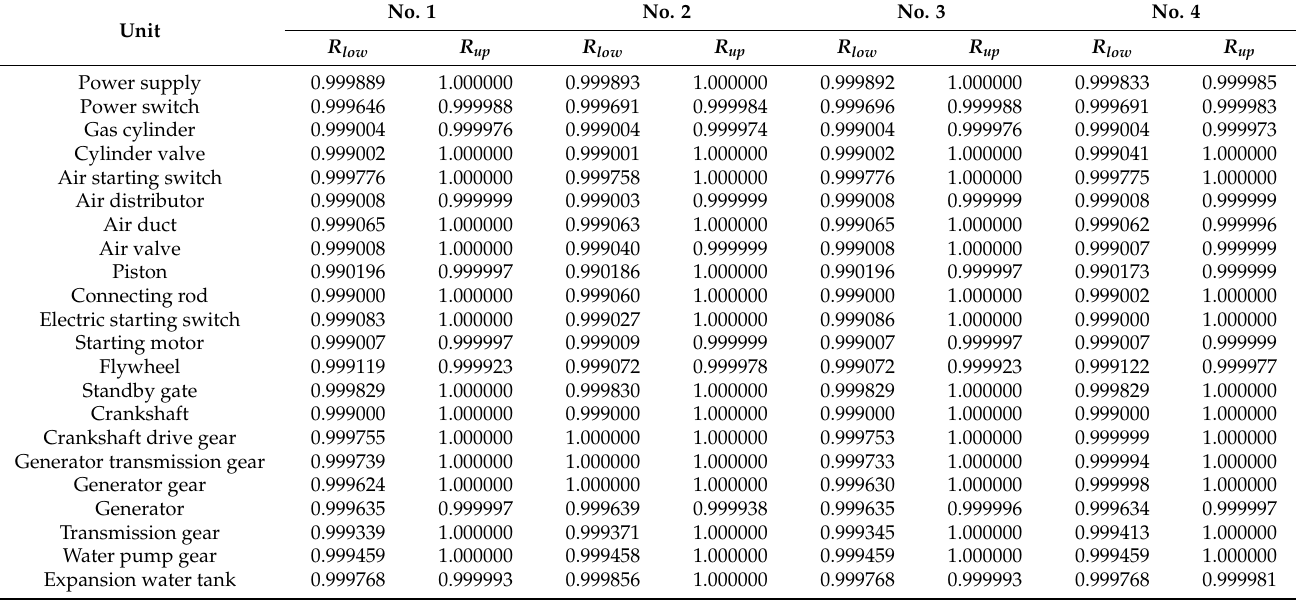
Table 6. Reliability of unit corresponding to Pareto solution set of the diesel engine optimization.